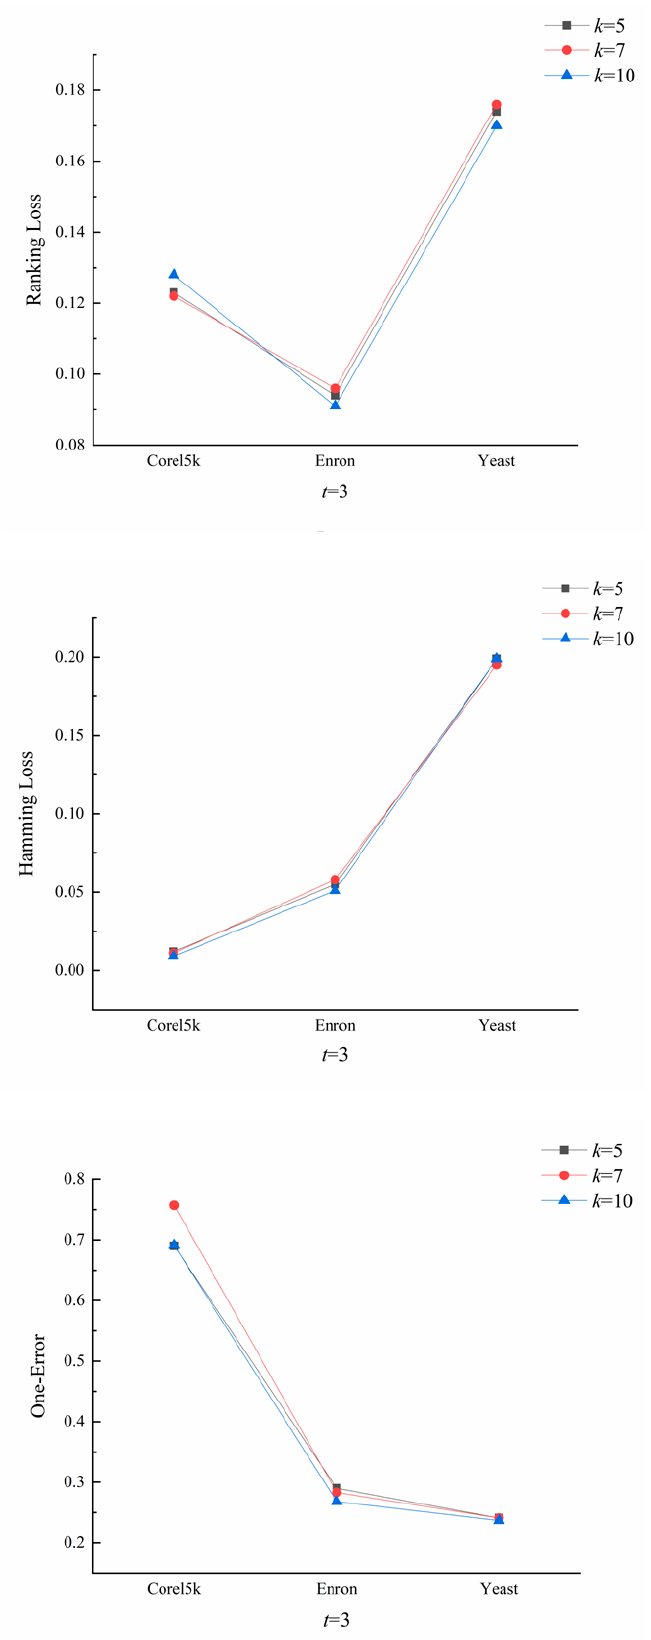
Figure 4. The results of different evaluation metrics in different datasets when t = 3.